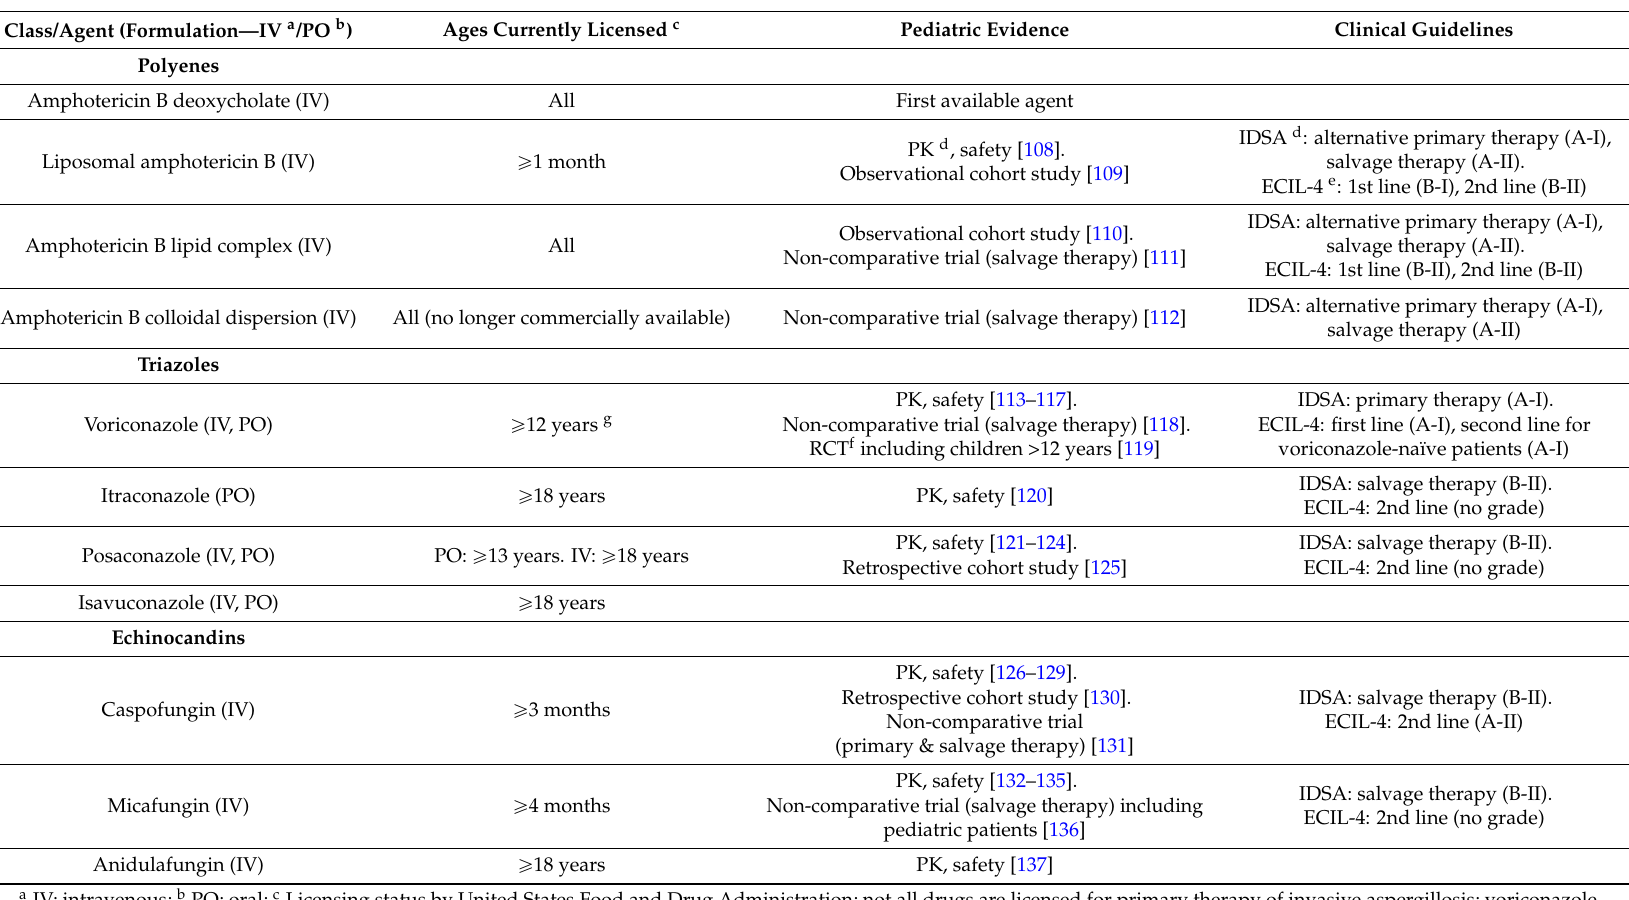
Table 3. Antifungals for Treatment of Invasive Aspergillosis: Pediatric Licensing and Evidence Supporting Use in